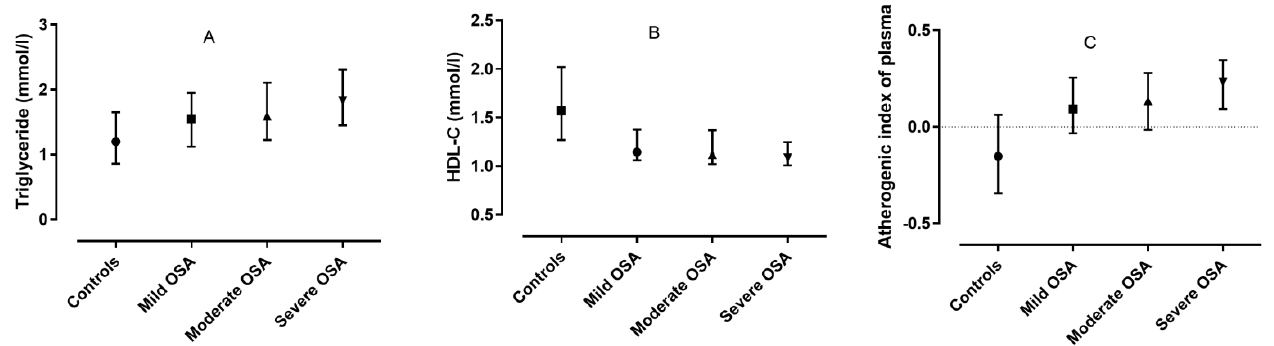
Figure 1. The relationship between lipid fractions and increasing OSA severity: A . Triglyceride; B . HDL-C; C . Atherogenic index of plasma.